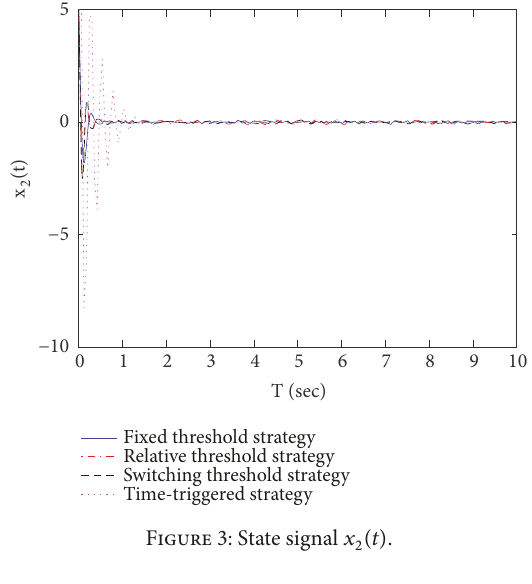
Figure 3: State signal 𝑥 2 (𝑡) .